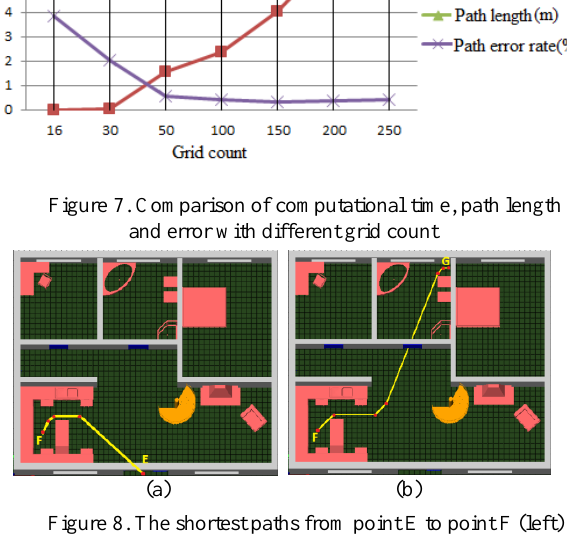
Figure 8. The shortest paths from point E to point F (left) and from point F to point G (right)